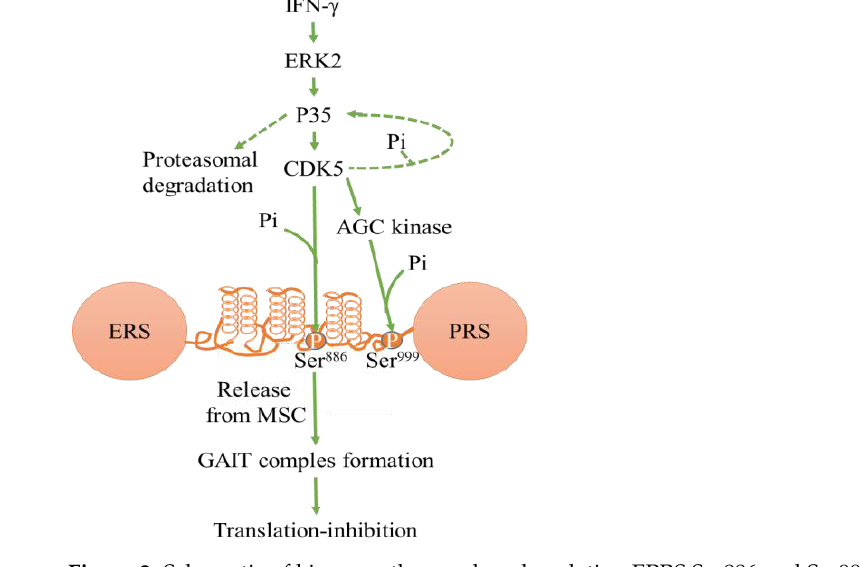
Figure 2. Schematic of kinase pathway phosphorylating EPRS Ser886 and Ser999. IFN- γ –activated CDK5 phosphorylate EPRS, leading to the formation of the GAIT complex. This inhibits inflammatory mRNA translation. Abbreviations- interferon-gamma (IFN γ ), glutamyl-prolyl tRNA synthetase (EPRS), IFN- γ –activated inhibitor of translation (GAIT), tRNA multisynthetase complex (MSC). (modified from Arif et al. [85]).